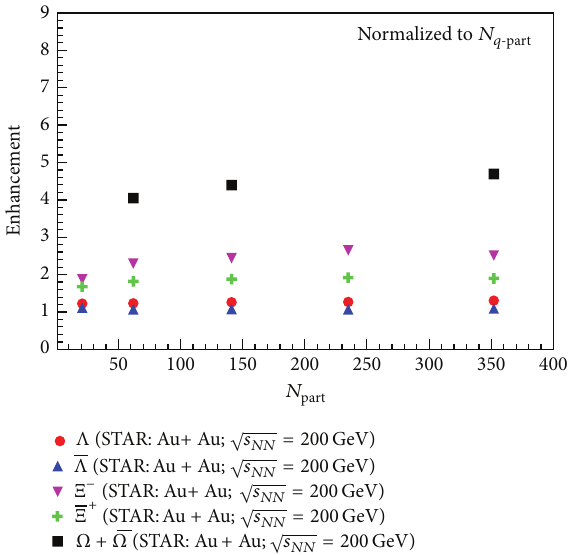
Figure 10: Midrapidity 𝑁 𝑞 -normalized enhancement of multi- -part strange baryons as a function of centrality for Pb + Pb collisions at √𝑠 = 17.3 GeV at 𝑁𝑁